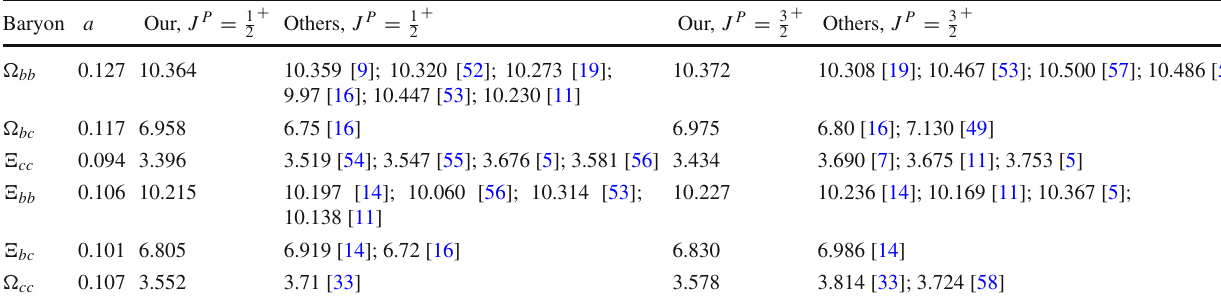
Table 2 Masses of ground states of double heavy baryons (in GeV) Baryon a